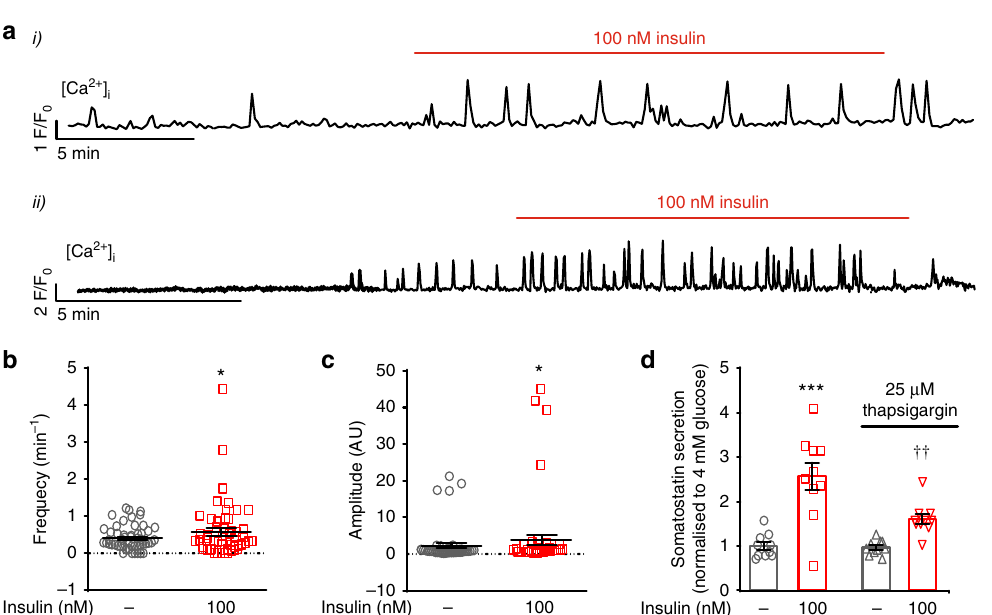
Fig. 4 Effect of insulin on cytosolic Ca 2 + . a Effects of insulin on [Ca 2 + ] i in δ cells in intact islets exposed to 4 mM glucose. Two representative traces are shown. b , c Frequency ( b ) and amplitude ( c ) of [Ca 2 + ] i oscillations at 4 mM glucose in the absence and presence of insulin. * p < 0.05 vs 4 mM glucose ( n = 54 δ cells in 11 islets from 8 mice of both sexes), Student ’ s t -test. d Effects of insulin (100 nM) on somatostatin secretion at 4 mM glucose in the absence and presence of the SERCA inhibitor thapsigargin (25 μ M). *** p < 0.001 vs 4 mM glucose; †† p < 0.01 vs 4 mM glucose and insulin in the absence of thapsigargin ( n = 10 experiments/4 male mice), one-way ANOVA followed by Sidak ’ s post hoc test. Data in b – d are presented as dot plots of individual experiments and/or mean values ± S.E.M. of all experiments with the experimental